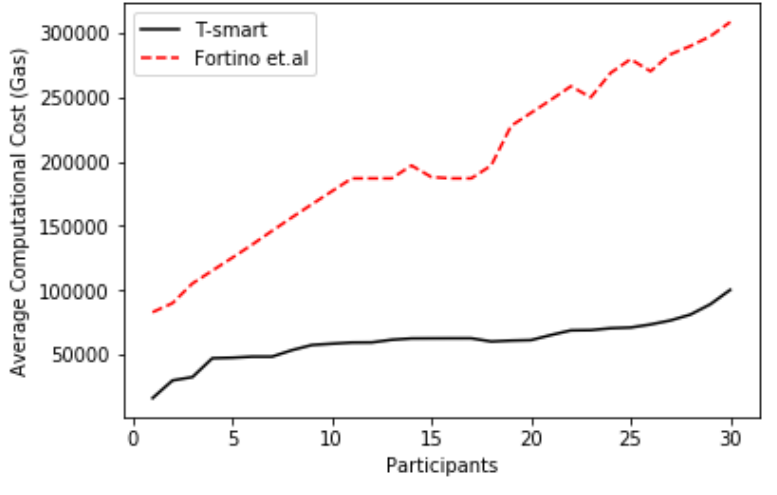
Figure 9. Average Computational Cost.